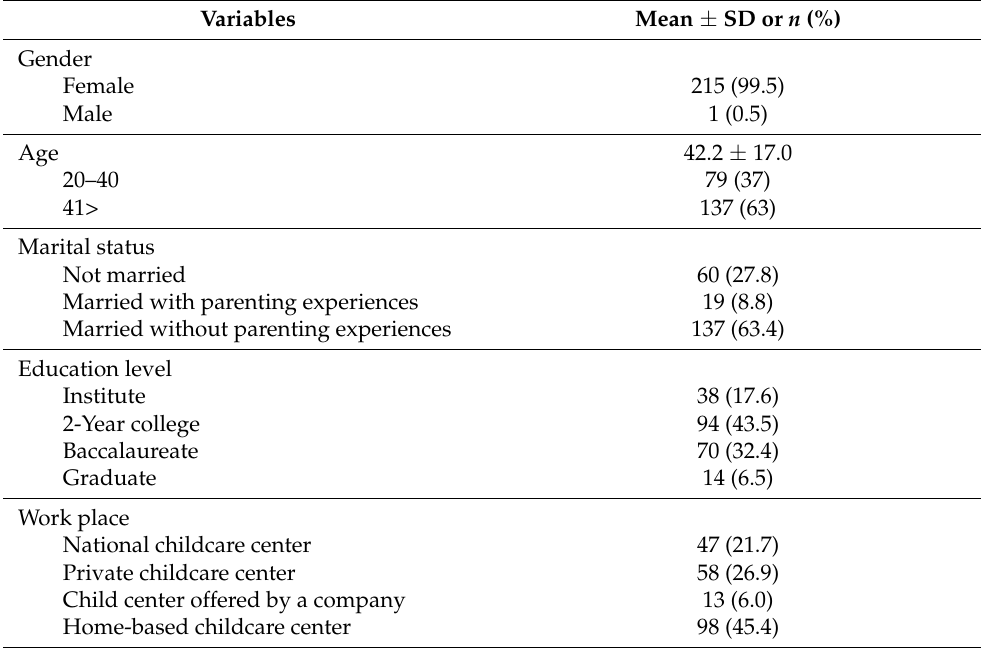
Table 1. General information of participants ( n =